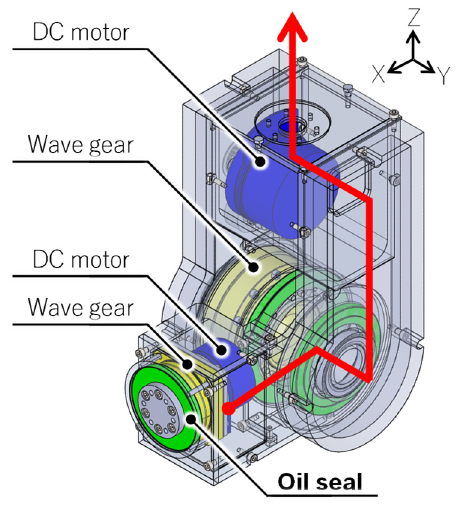
Figure 6. ( a ) Front view, ( b ) Side view. Interlocking unit.